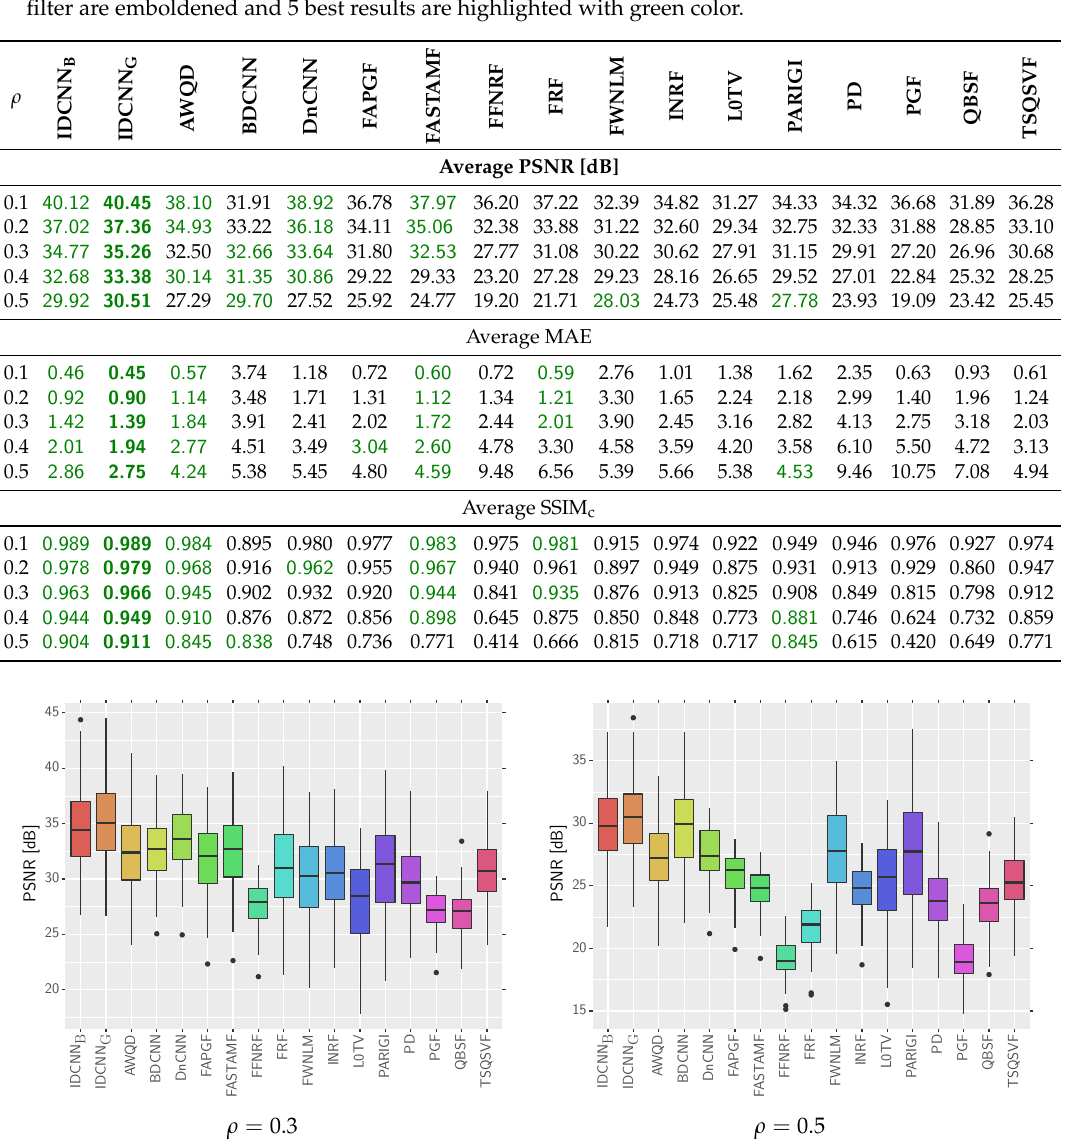
Figure 12. Box plots presenting the distributions of the obtained results for the analyzed methods using the test dataset